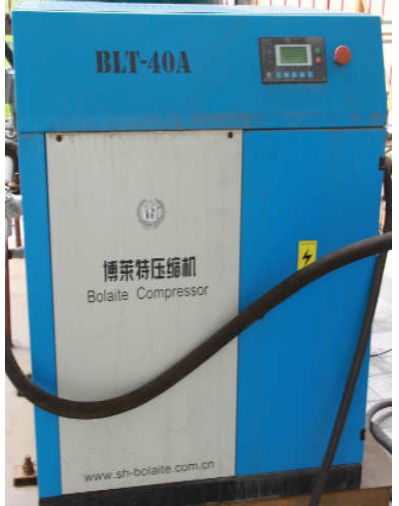
Figure 8. Air compressor.